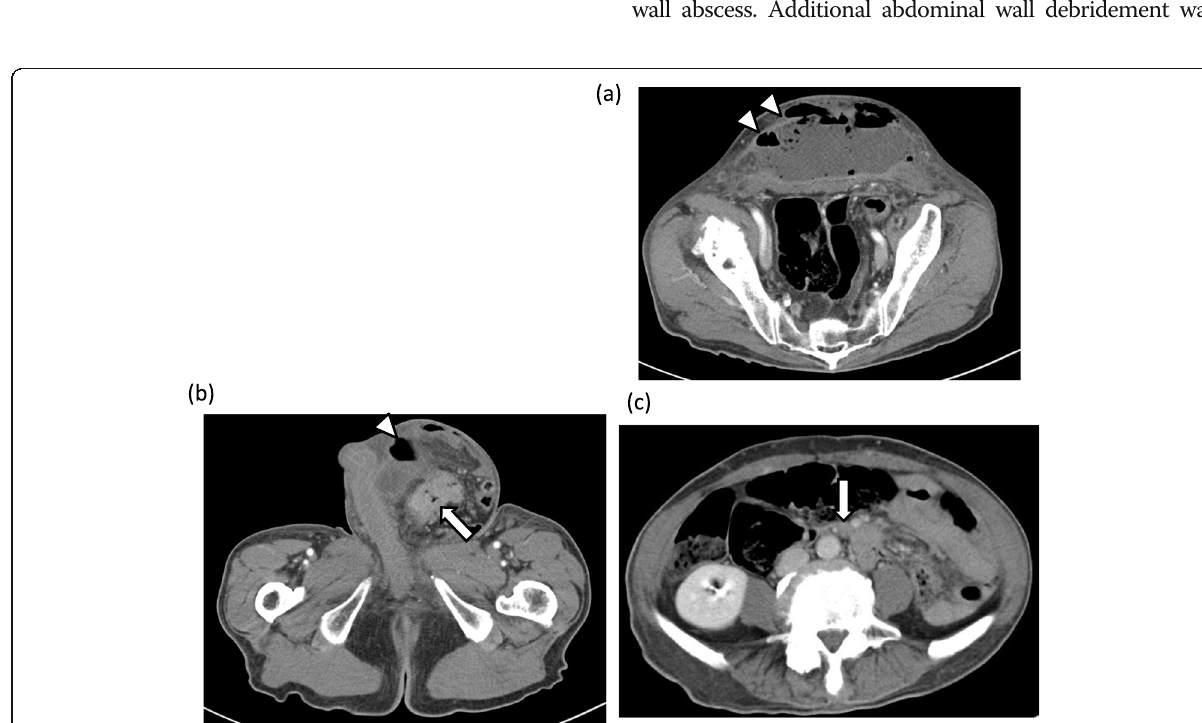
Fig. 2 a , b Computed tomography scan showing air-containing fluid in the lower abdominal wall (arrow head), localized wall thickness of the sigmoid colon in the left groin (arrow), and ( c ) swollen lymph nodes along the IMA and abdominal aorta